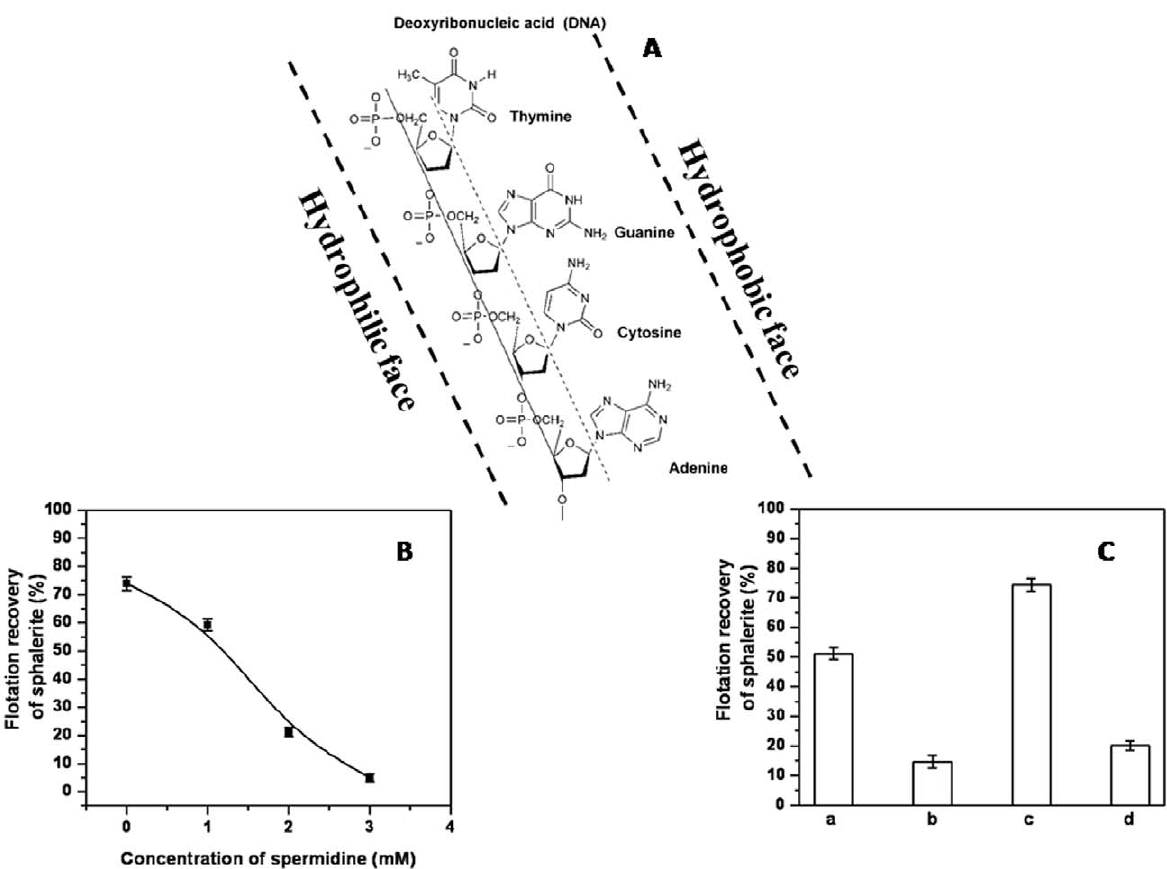
Figure 6. Schematic diagram of the amphipathic nature of ssDNA. (A) Amphipathic structure of ssDNA indicating the hydrophobic and the hydrophilic faces; (B) - Effect of spermidine concentration on the ssDNA mediated flotation of sphalerite; (C) - Effect of depurination of DNA on the